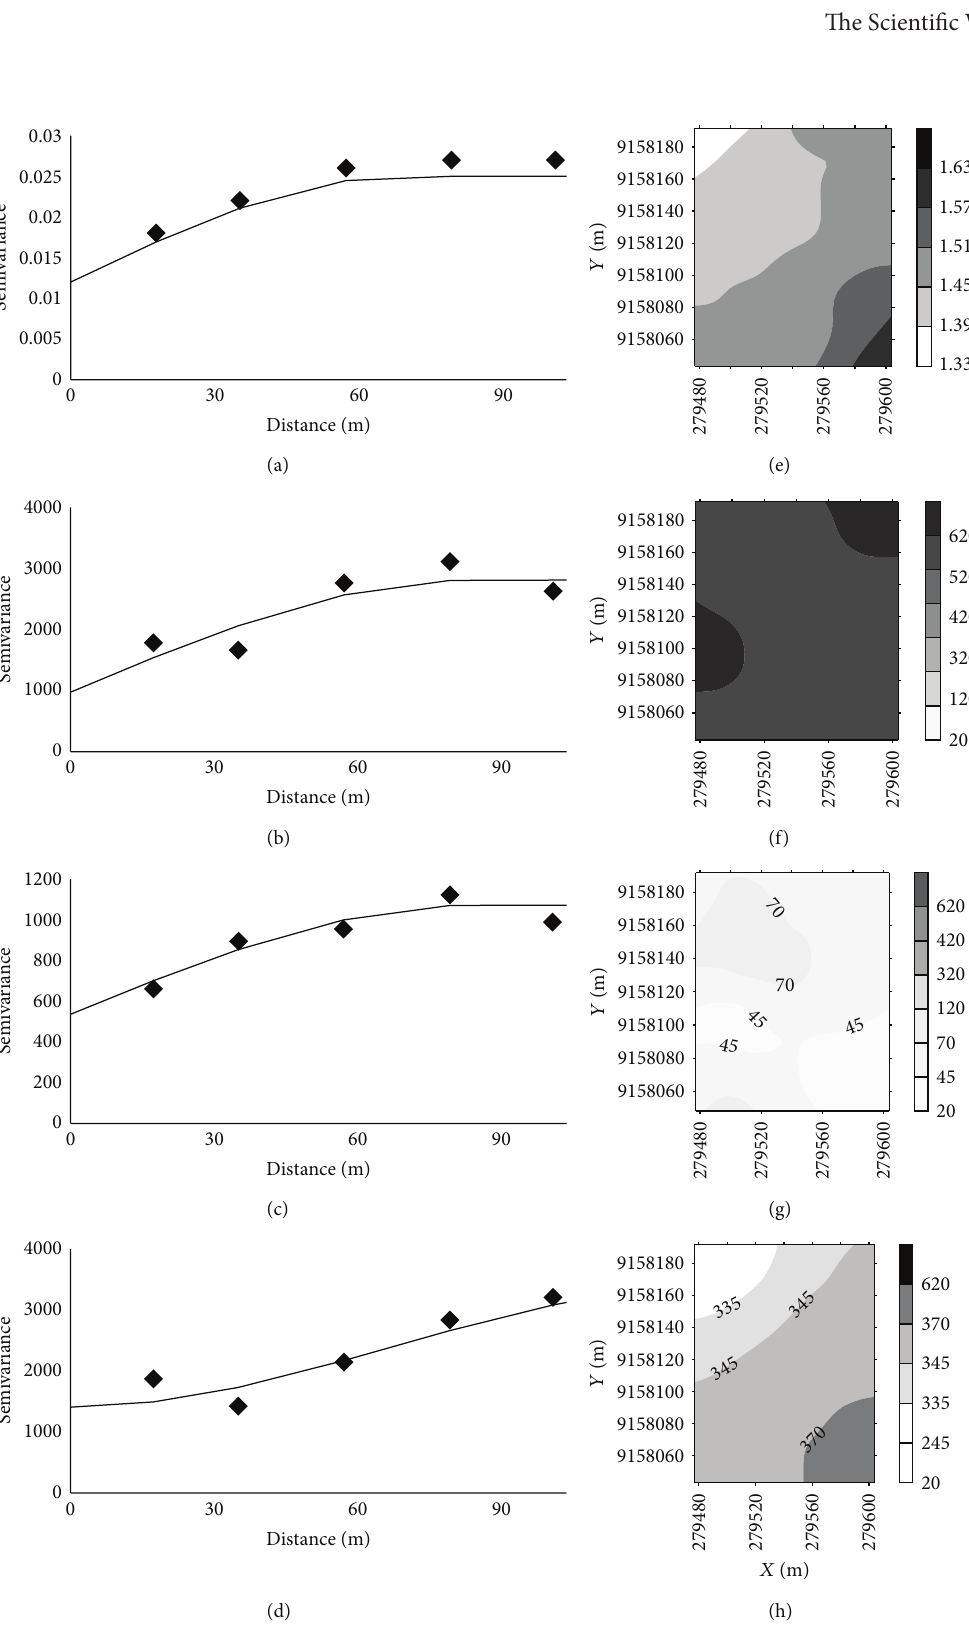
Figure 4: Semivariograms of the parameters of bulk density (a), sand (b), silt (c), and clay (d) and contour maps of bulk density (e), sand (f), silt (g), and clay